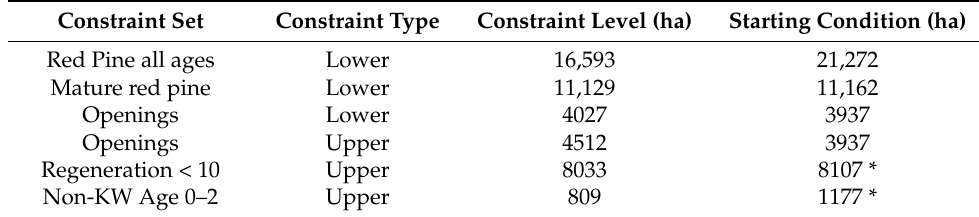
Table 1. Starting condition and general constraint levels used to represent multiple management objectives of the Hiawatha National